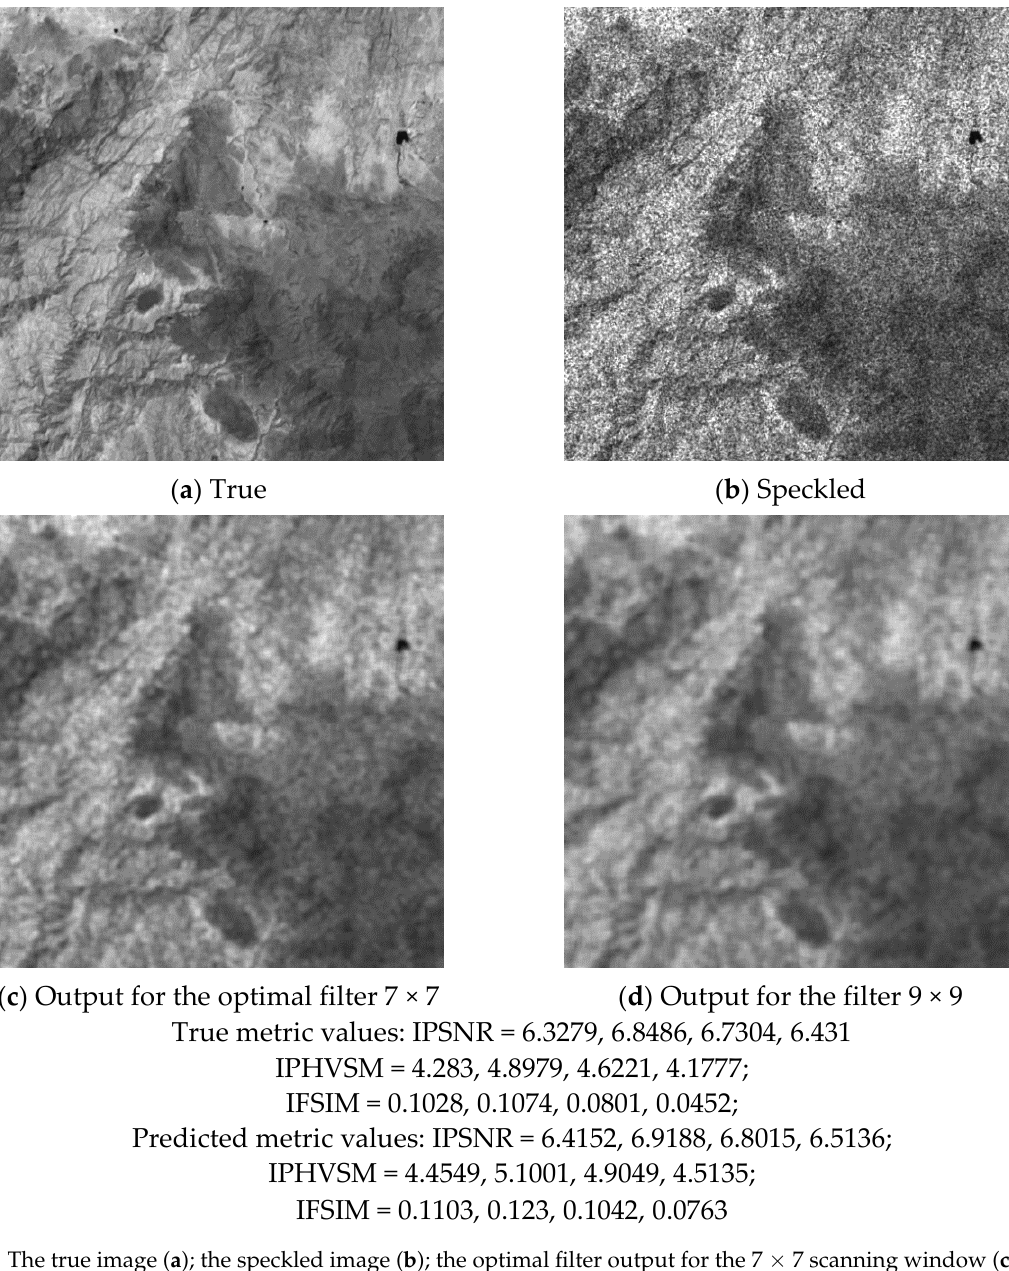
Figure 16. The true image ( a ); the speckled image ( b ); the optimal filter output for the 7 × 7 scanning window ( c ); and the filter output for the 9 × 9 scanning window ( d ).